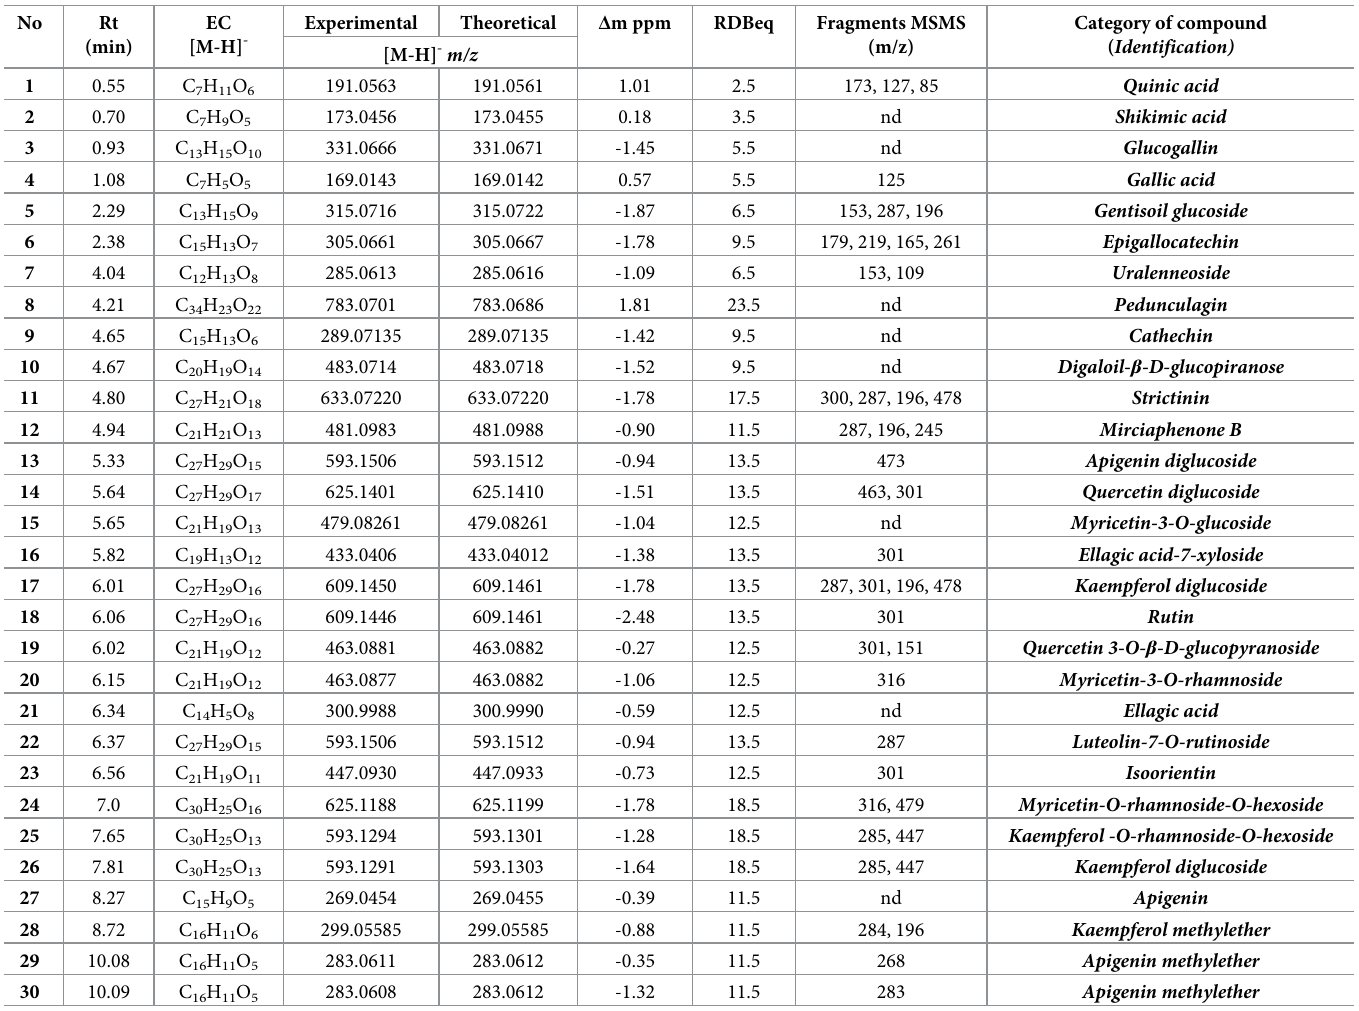
Table 5. LC(ESI-)HRMS of C . creticus methanol